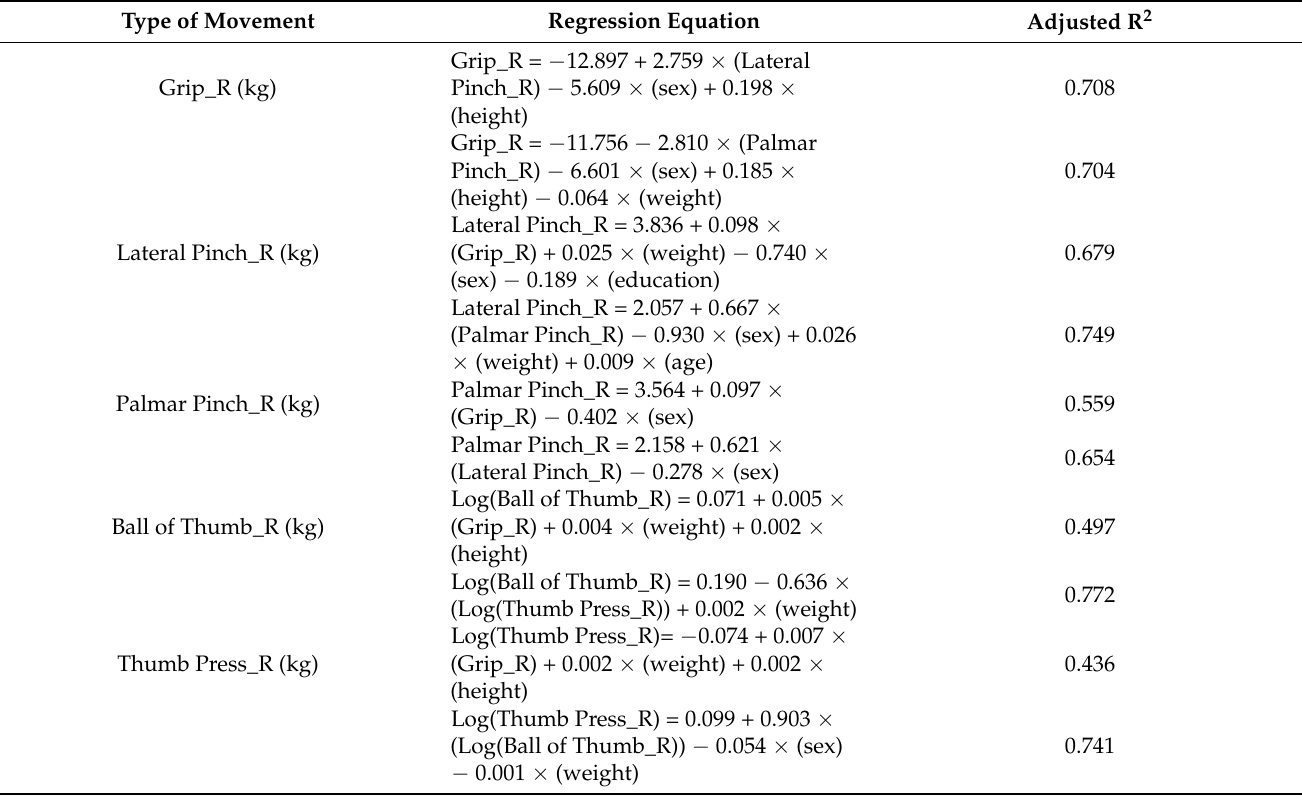
Table 8. Proposed prediction models for five different types of strength in the right hand using different types of strength in the right hand and demographic